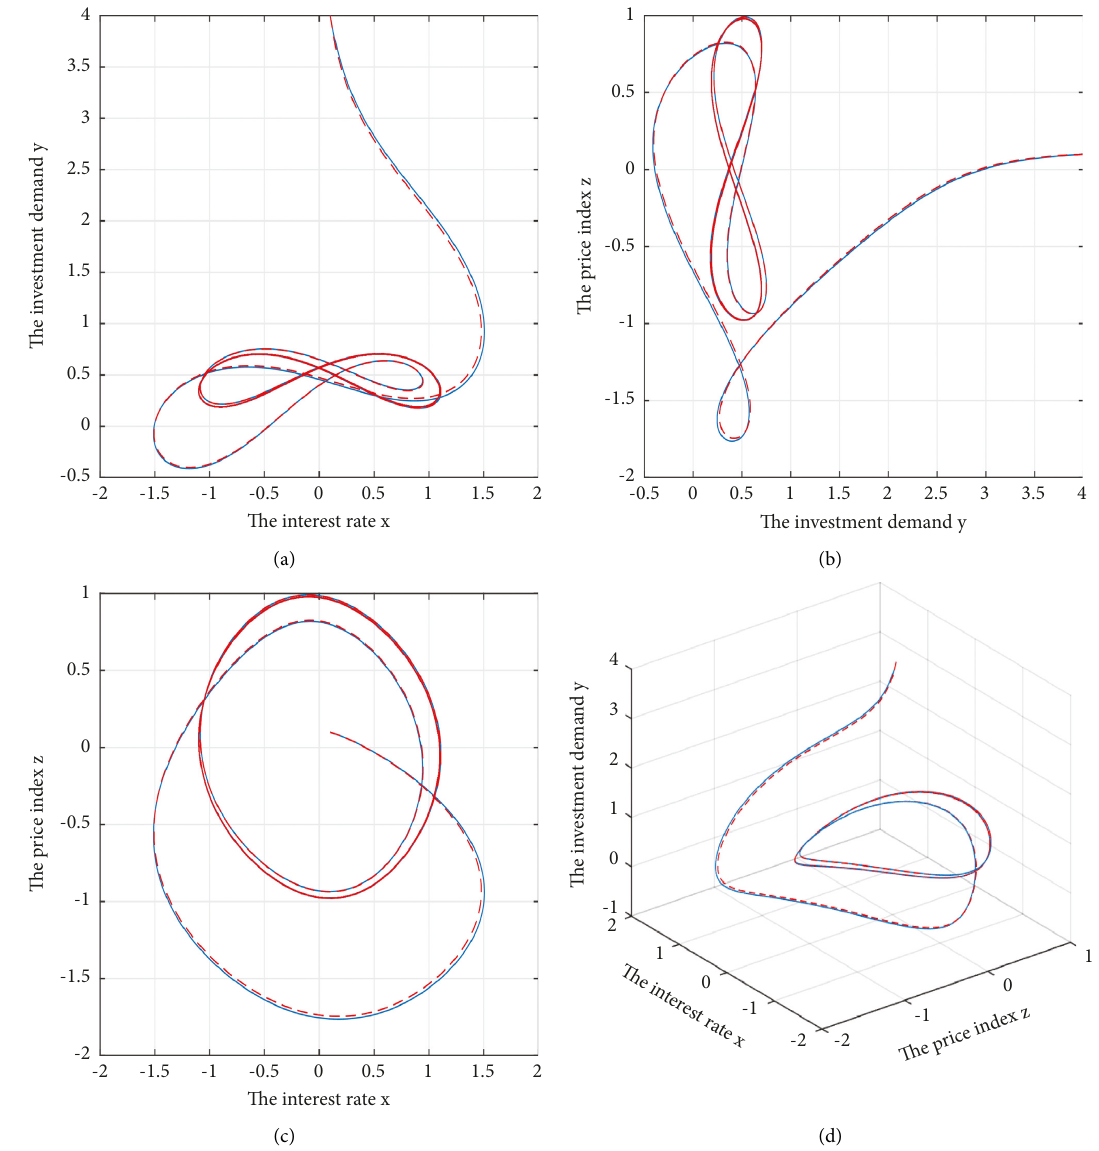
Figure 9: The phase portrait of the proposed model where (a) the demand of investment versus the rate of investment, (b) the index of price versus the demand of investment, (c) the index of price versus the rate of investment, and (d) the chaotic behaviour of the system with the input parameter a � 0 . 3 , b � 1 . 0, and c � 0 . 3 to identify the influence of these input parameters on the chaos of the